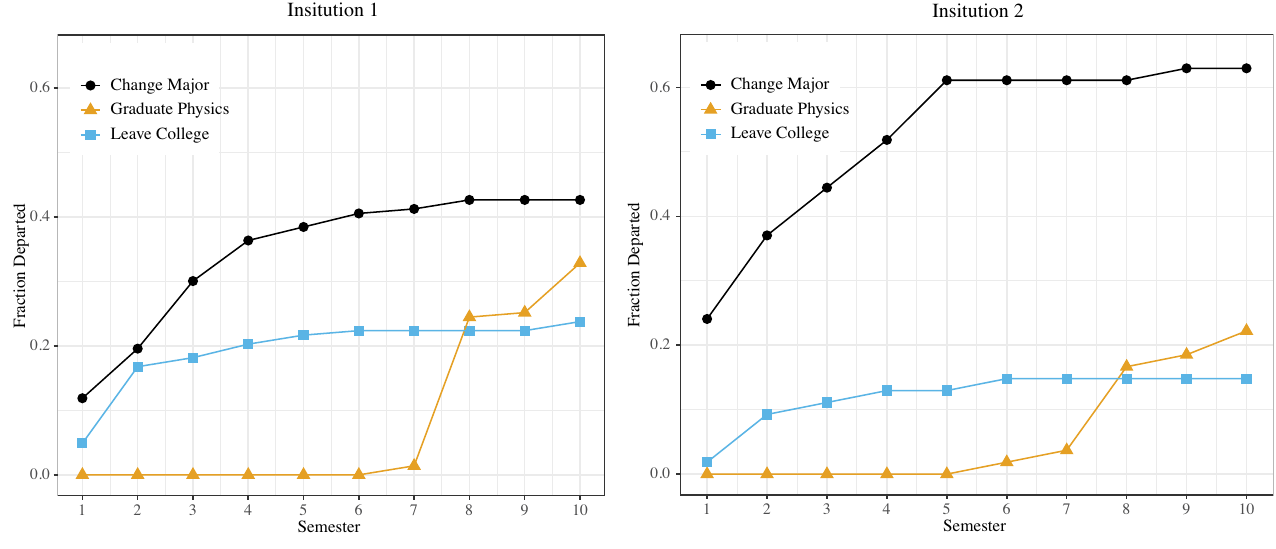
FIG. 2. Fraction departed or graduated for students entering the university declared as physics